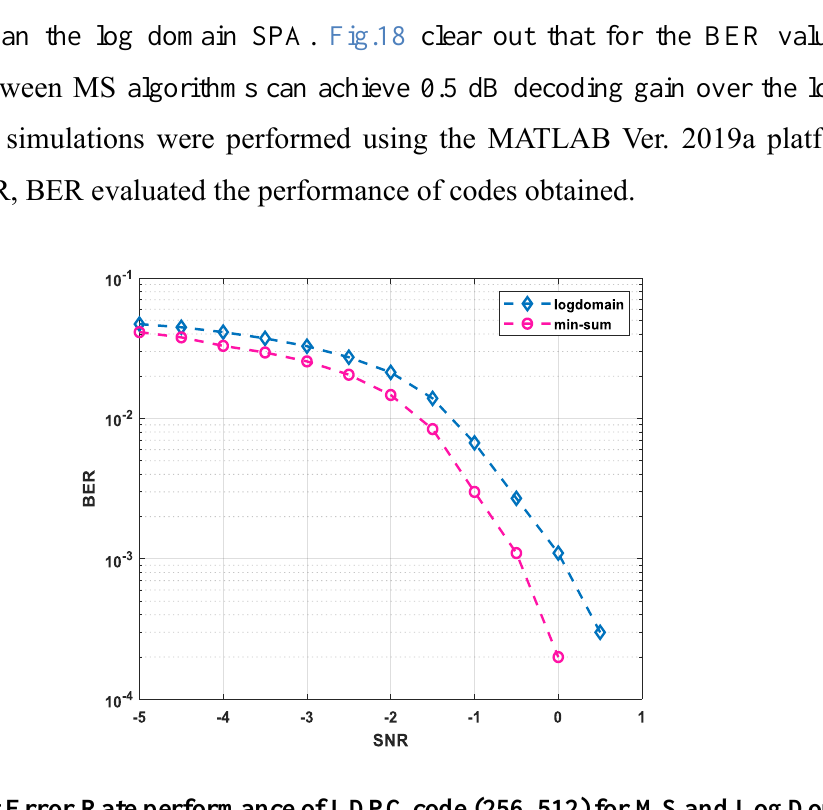
Fig. 18. Bit Error Rate performance of LDPC code (256, 512) for MS and Log Domain. 5 FPGA S nthe i